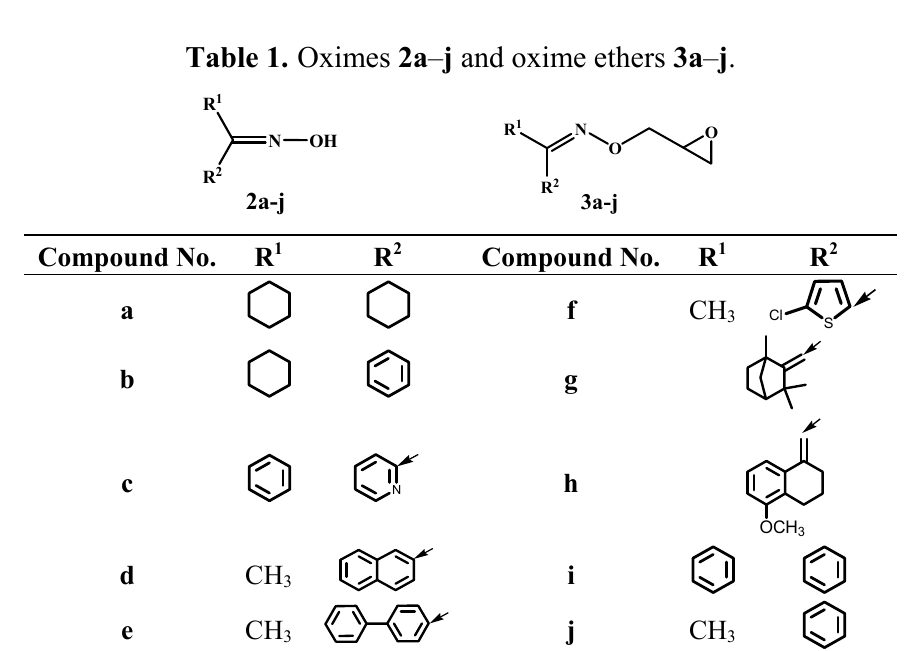
Table 1. Oximes 2a – j and oxime ethers 3a – j